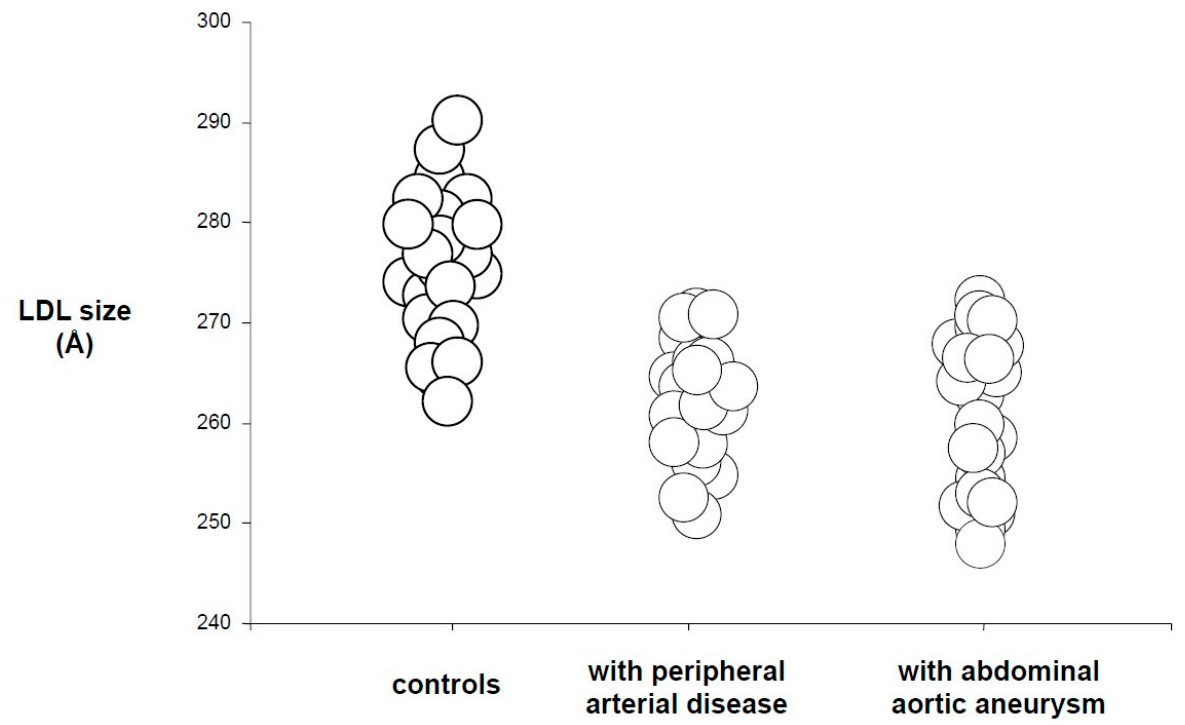
Figure 1. LDL size in patients with peripheral arterial disease, abdominal aortic aneurysm and controls (adapted from [23,24]).